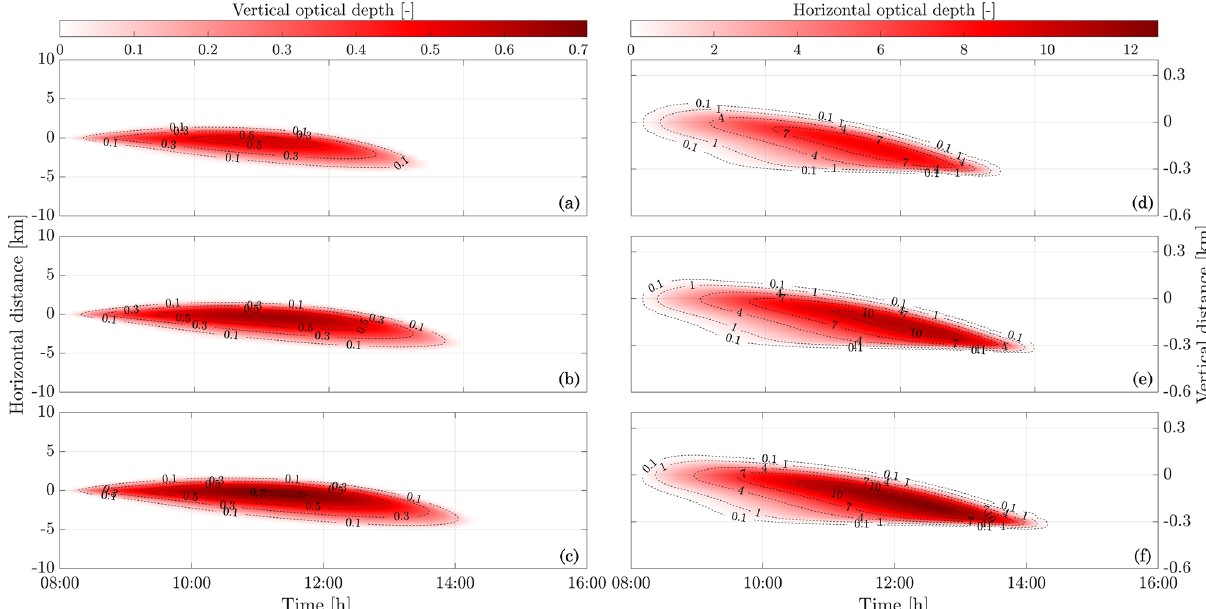
Figure 13. Contours of optical thickness along the vertical (a, b, c) and horizontal (d, e, f) directions for different black carbon mass emission (c, f) , respectively. The horizontal axis is centered on the flight location. The vertical axis represents indices: 20 (a, d) , 40 (b, e) , 60mgkg − 1 fuel the distance with respect to the altitude after vortex sinking. The flight altitude before vortex sinking is at a pressure altitude of 10.6km. Vortex sinking caused the plume to settle at a new altitude, 112m lower, corresponding to the origin of the vertical axis. We apply a wind shear of 0.002s − 1 , causing the contrail to move left of the initial center line while sinking. An optical depth of 0.1–0.2 is usually given as a contrail detection threshold through satellite sensing (Kärcher et al.,